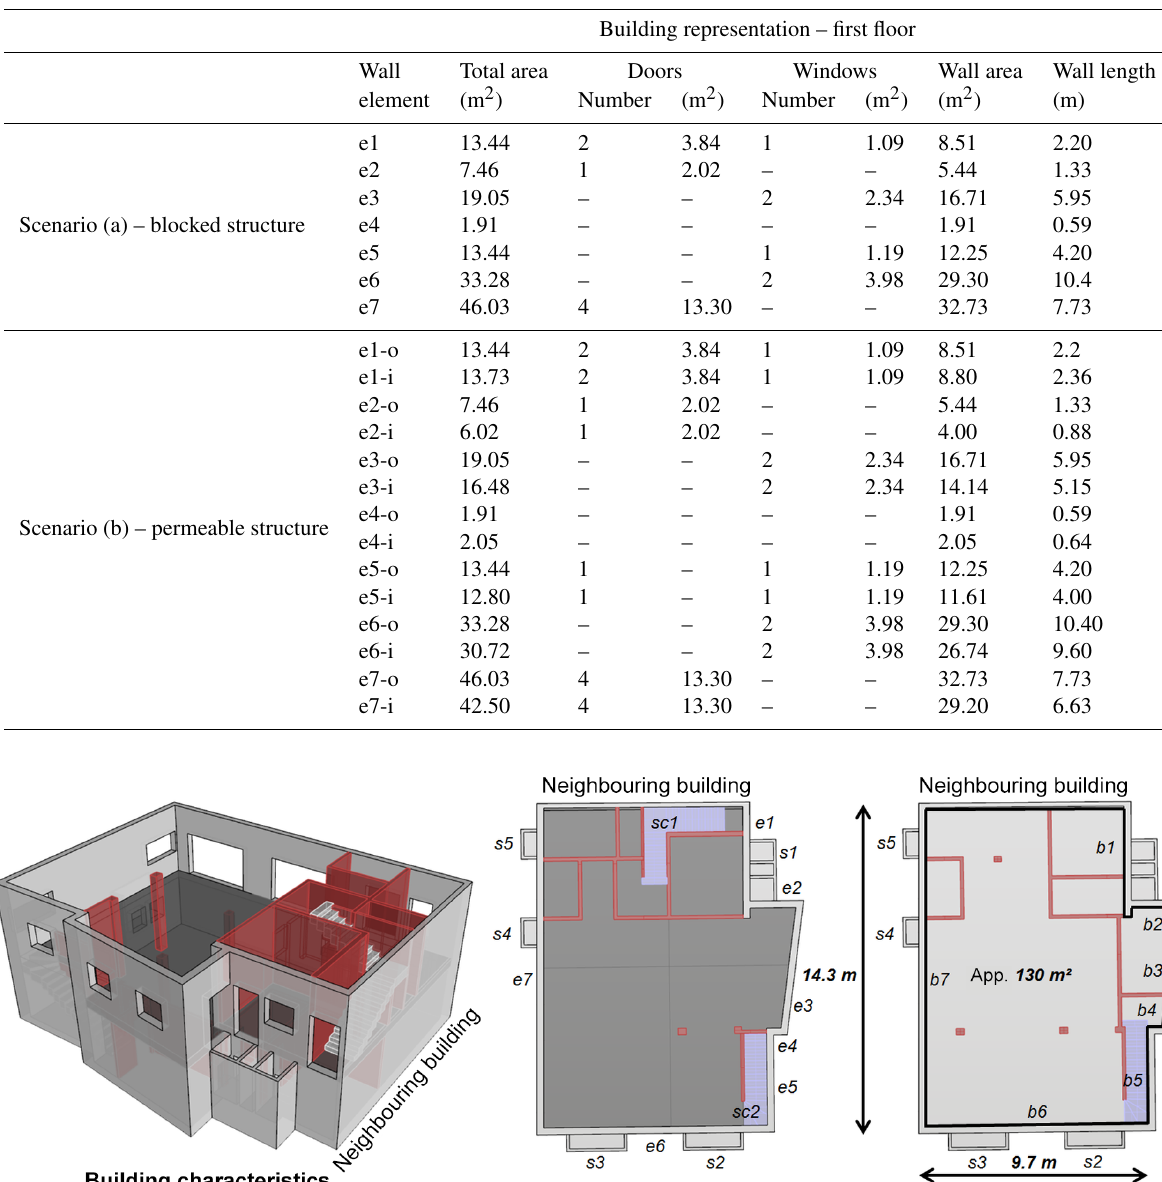
Table 1. Building representation for the considered scenarios (a), with a fully blocked structure, and (b), assuming all doors, light shafts and windows to be entirely open; wall element notations refer to Fig. 4; for scenario (b), index “o” means the outside of the wall element, and “i” refers to the inside.